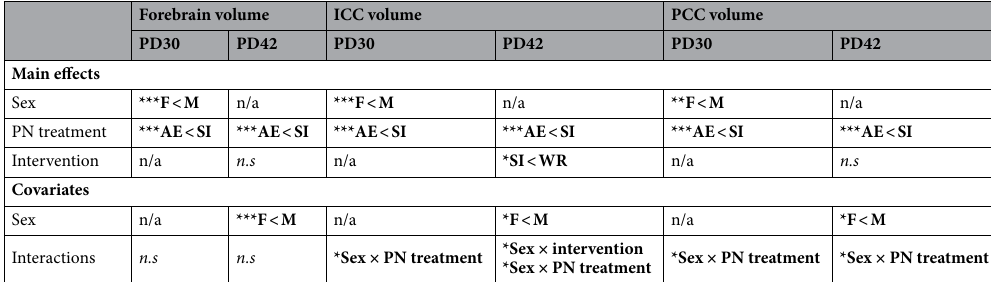
Table 1. Cross-sectional analysis of forebrain, ICC, and PCC volume data collected on PD30 and 42. Significant values are in bold. ***p < .001, ** p < .01, * p < .05; n/a variable not included in analysis, n.s. non- significant difference.